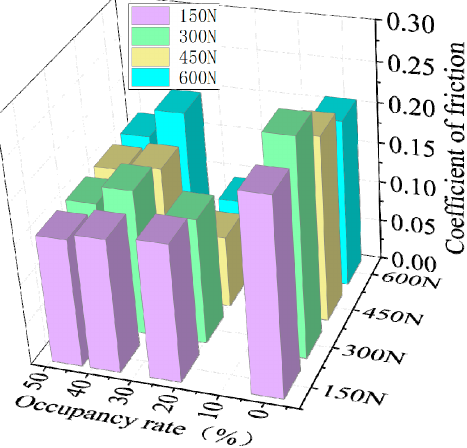
ff ect of groove density on the coe ffi cient of Figure 13. Effect of groove density on the coefficient of friction. Figure 13. E